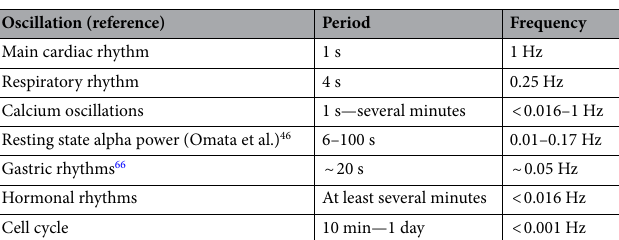
Table 1. Biological processes with low-frequency oscillations. The list of oscillations and data on their characteristics are from Goldbeter and Berridge 67 unless otherwise indicated.